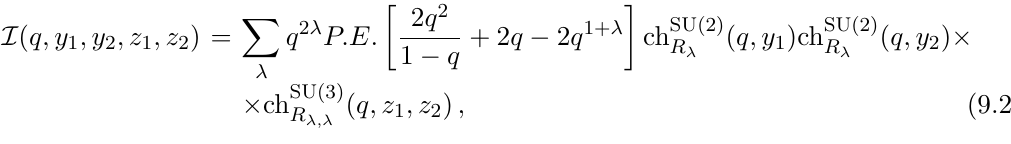
Figure 5 . The above SCFT is inconsistent because of the SU(2) anomaly of the would be interesting to study how this inconsistency is manifested in the chiral algebra